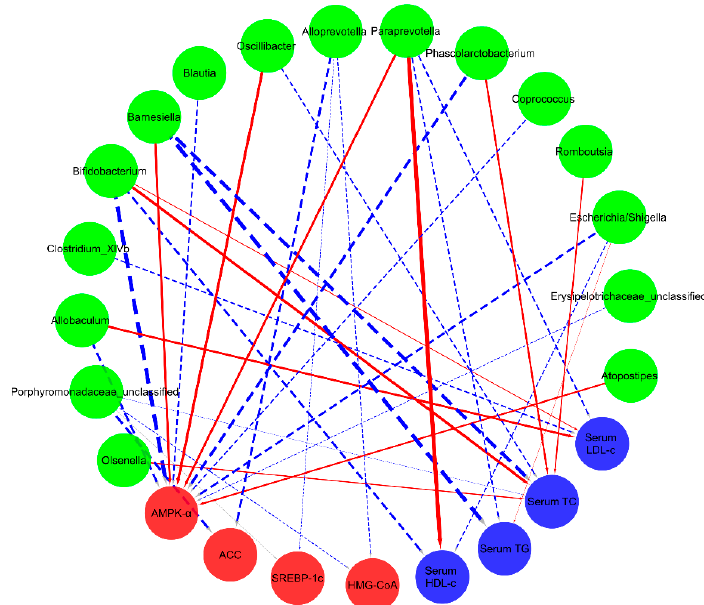
Figure 6. Visualization of the correlation network according to the partial correlation between the caecal microbiota of significant differences and the parameters associated with lipid metabolism disorder. Each node represents the gut microbiota genera and parameters associated with lipid metabolism disorder. The solid red line and dotted blue line represent positive and negative correlation, respectively. In addition, the line width indicates the strength of correlation. Only the significant edges are drawn in the network using the Spearman correlation test (|r| > 0.7, FDR adjusted p < 0.01).